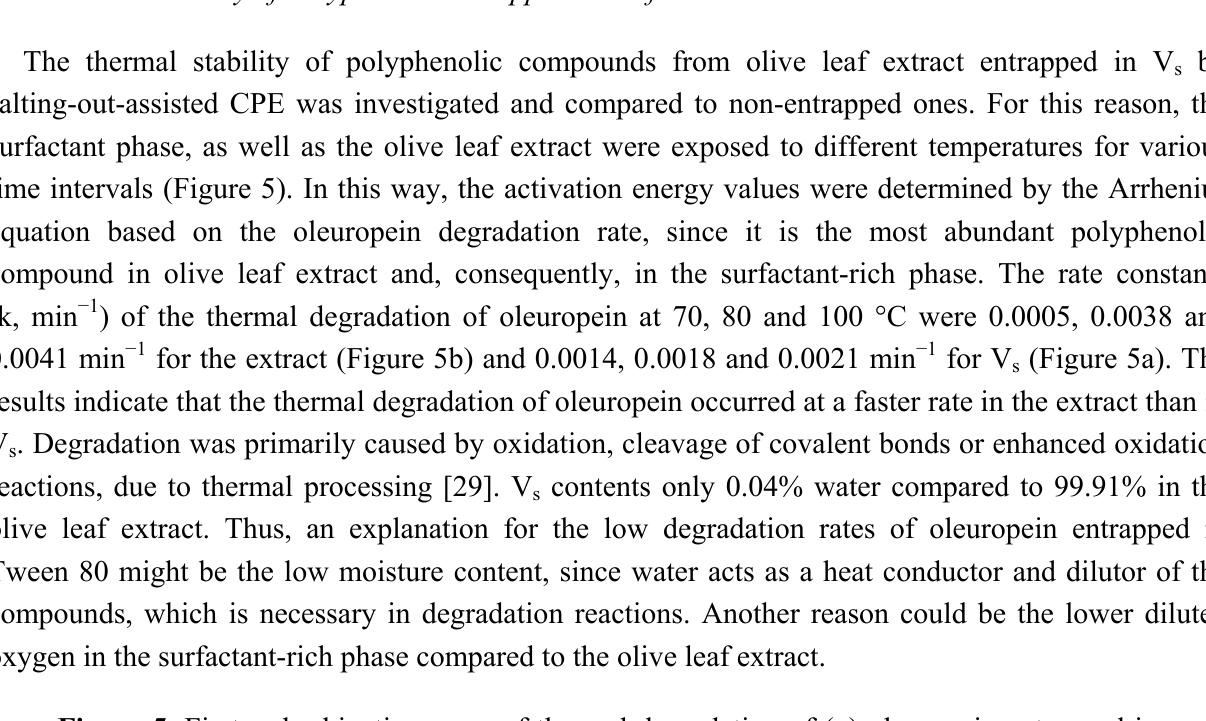
Figure 5. First-order kinetic curves of thermal degradation of ( a ) oleuropein entrapped in the surfactant-rich phase and ( b ) oleuropein present in the olive leaf extract; ( c ) lnk vs. 1/T kinetic curves for the thermal degradation of non-entrapped and entrapped